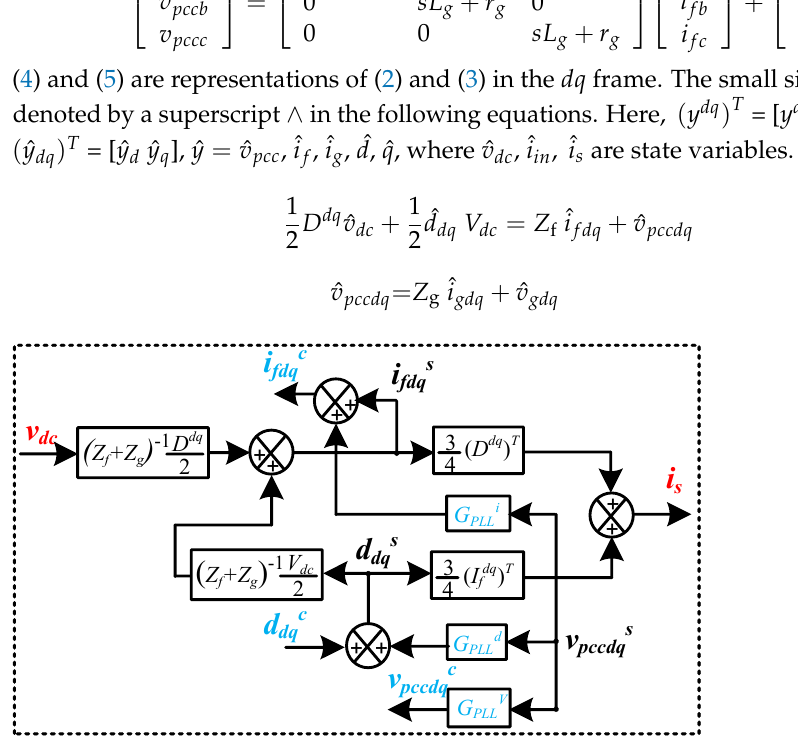
Figure 3. Small signal impedance model of GC operating in open loop with PLL